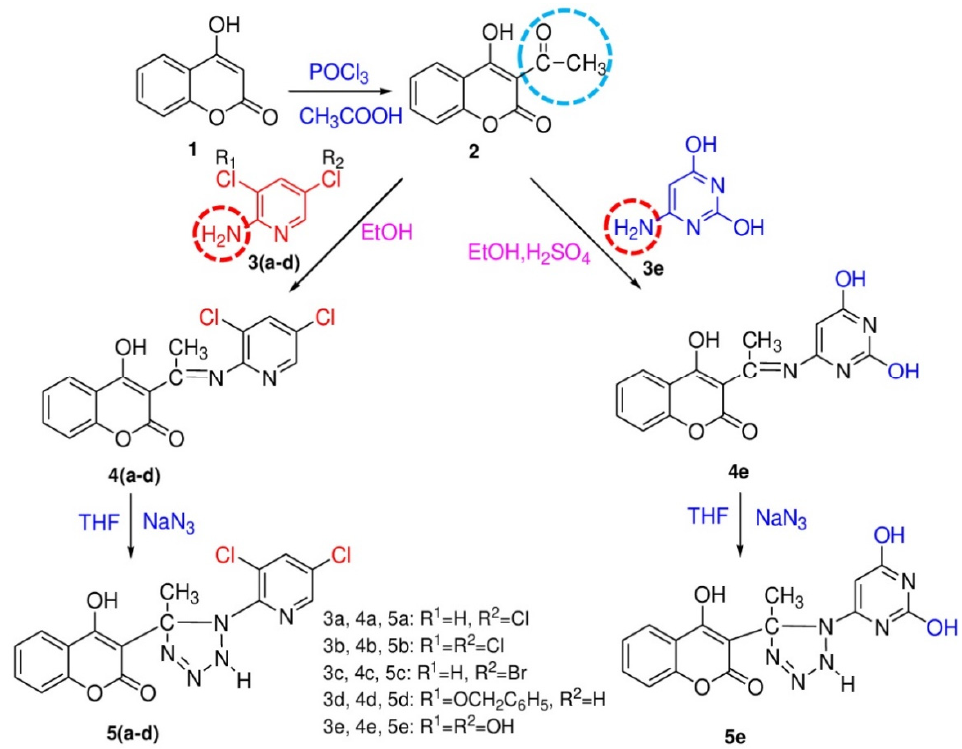
Scheme 1. Synthetic procedure to obtain the analogs of tetrazole